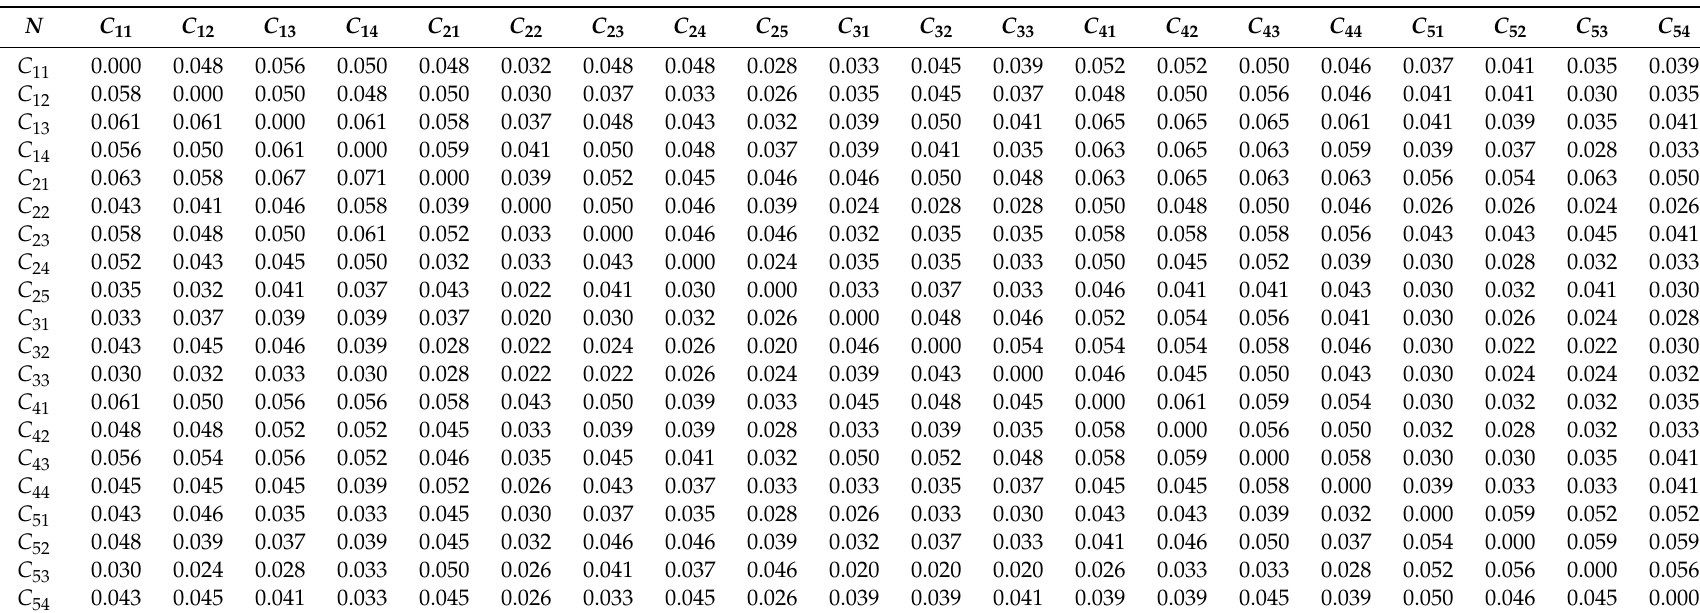
Table A2. The normalization matrix of criteria